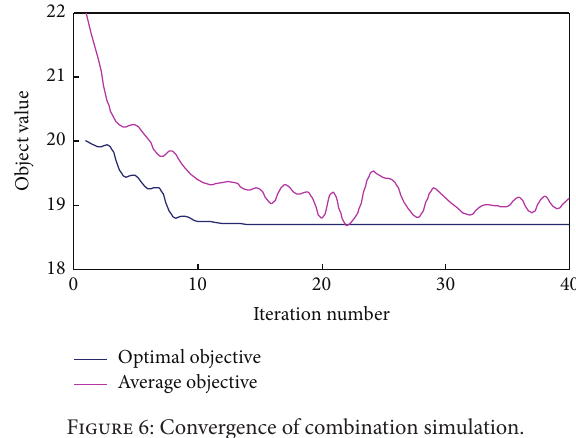
Figure 6: Convergence of combination simulation.